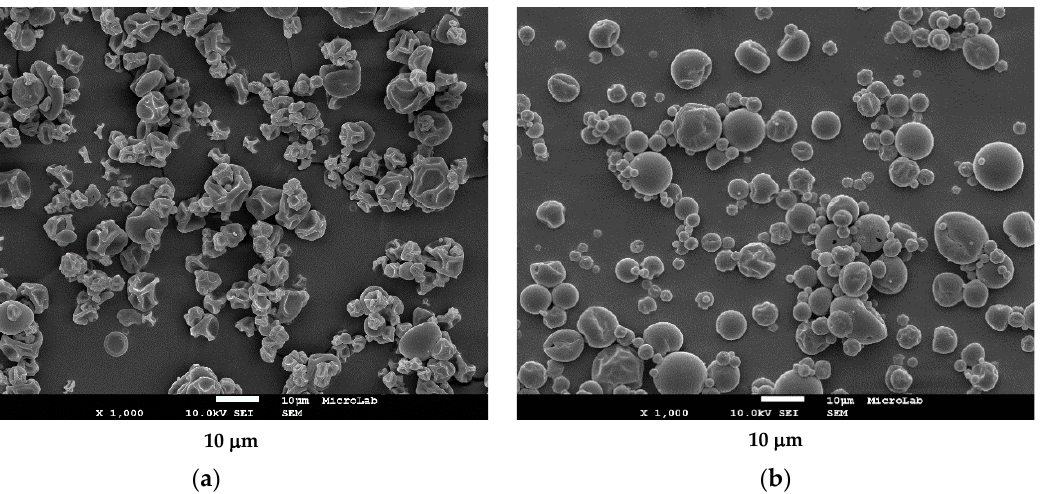
Figure 4. Scanning Electron Microscopy (SEM) images (magnification ×1000) of microparticles loaded with tomato pomace extract in different wall materials. ( a ) Arabic gum particles; ( b ) Inulin particles.